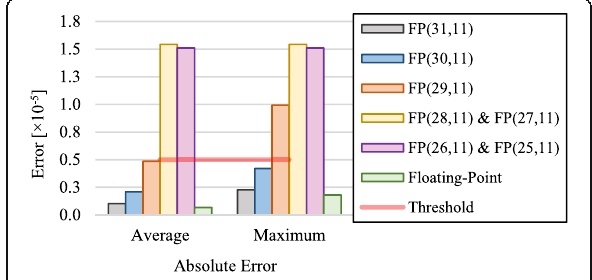
Fig. 12 Average and maximum absolute error for the investigated variables